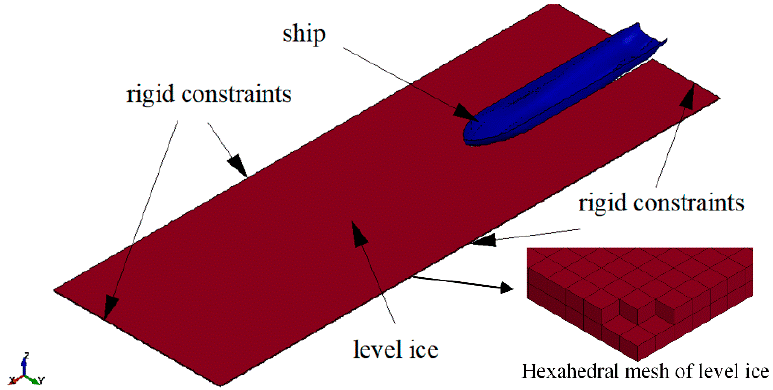
Figure 5. Computational domain and boundary conditions.